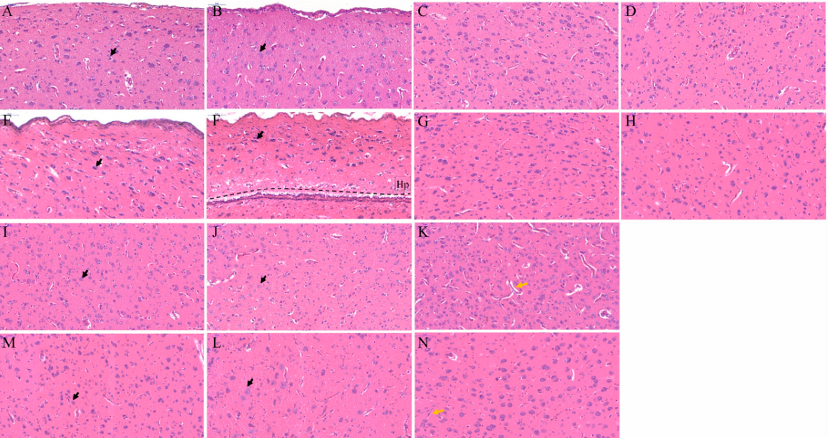
Figure 3. Identification of histological features of telencephalon in cerebral hernia and wild type chickens based on hematoxylin and eosin staining. ( A – N ) The H, Hp, M, N, St, P, and A regions are represented in figure ( A , E ), ( B , F ), ( C , G ), ( D , H ), ( I , M ), ( J , L ), and ( K , N ) in wild type and cerebral hernia type chickens, respectively. The state of cells and blood vessels are marked with black and yellow arrows, respectively. The Hp region in cerebral hernia type is located above the black dotted line in image F. Scale bars = 50 μ m.